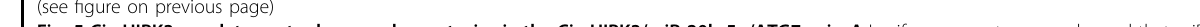
Fig. 5 CircHIPK3 regulates autophagy and apoptosis via the CircHIPK3/miR-20b-5p/ATG7 axis. A Luciferase reporter assay showed that miR- 20b-5p mimics directly binds to the 3 ′ -UTR of ATG7 and inhibits luciferase activity. * P < 0.05 compared with the NC-mimics group. B ATG7 protein expression was detected by western blotting. n = 3. * P < 0.05 compared with the MNC group. # P < 0.05 compared with the INC group. C The protein expression levels of LC3-II, P62, and ATG7 were measured by western blotting. n = 3. D The intracellular ROS level was detected by fl ow cytometry. n = 3. E Annexin V-FITC/PI fl ow cytometry was used to evaluate apoptosis under different treatment conditions. n = 3. F Apoptosis-related proteins, including procaspase-3, cleaved caspase-3, Bax, and Bcl-2, were detected by western blotting. n = 3. * P < 0.05 compared with the H/R group. # P < 0.05 compared with the H/R + sicircHIPK3 group.